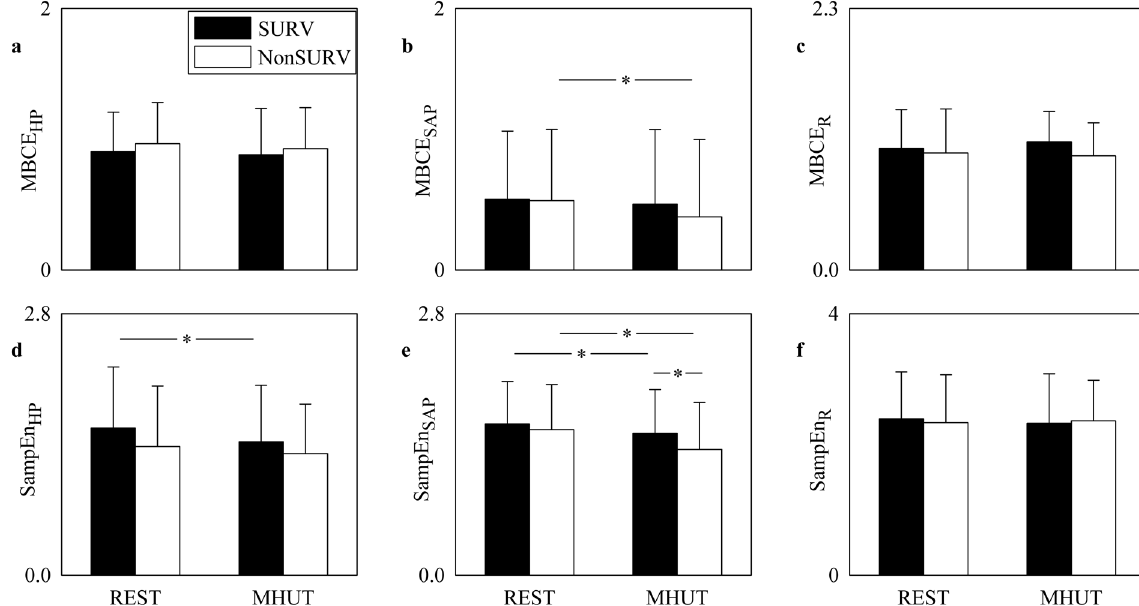
Figure 2. The bar graphs show MBCE and SampEn computed on HP series in ( a ) and ( d ) respectively, on SAP series in ( b ) and ( e ) respectively, and on R series in ( c ) and ( f ) respectively, as a function of the experimental condition (i.e. REST and MHUT) in SURVs (dark bar) and NonSURVs (white bar). Data are reported as mean plus standard deviation. The symbol *indicates p <